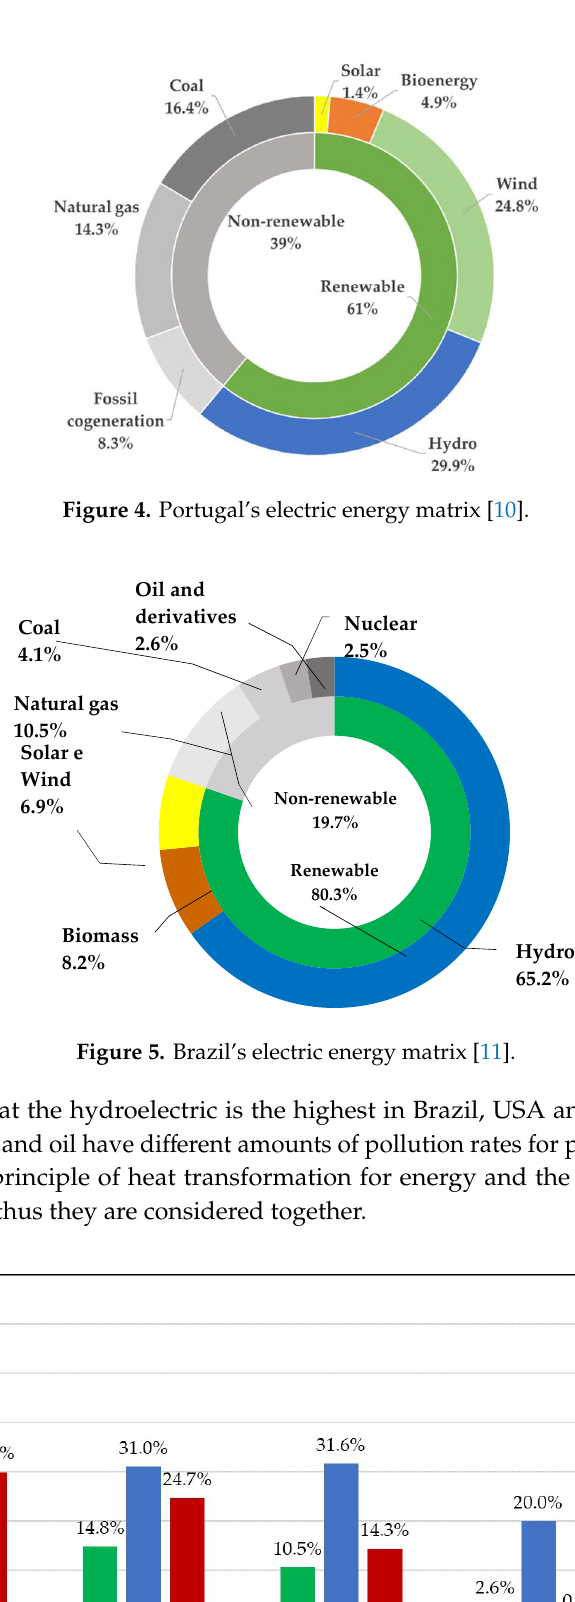
Figure 4. Portugal’s electric energy matrix [10].